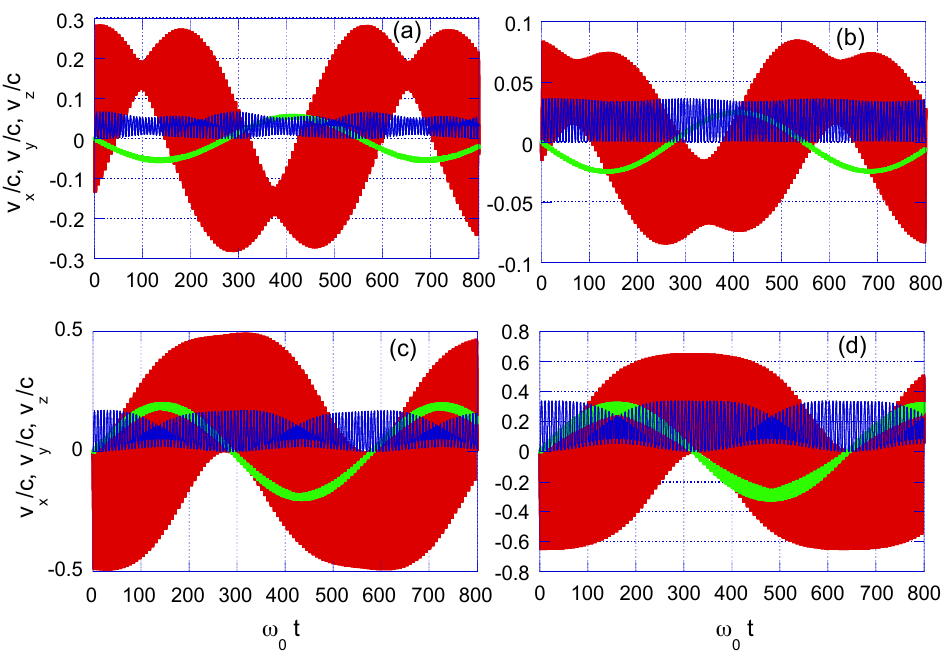
Figure 3. Time evolution evolution of v x ( t ) / c (in red), v y ( t ) / c (in green) and v z ( t ) / c (in blue). The same cases as in Figure 1 are displayed. The low-frequency modulation superimposed on transverse velocity components is apparent. v z is also modulated, but with a net positive mean value, which accounts for the observed net drift of the trajectories in the positive z direction for E kin 0 =